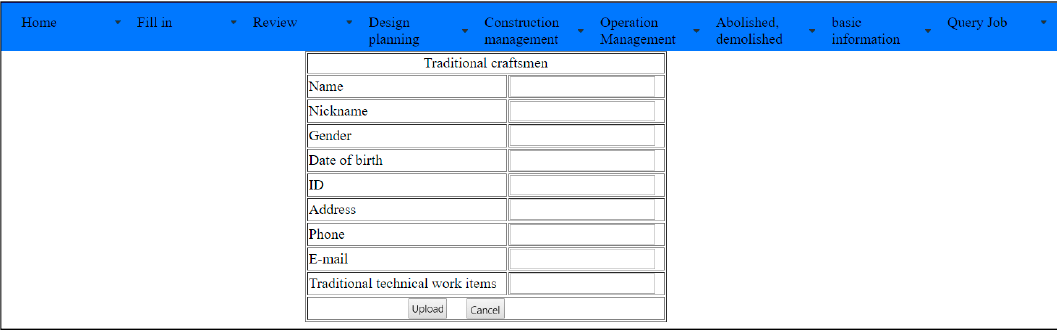
Figure 10. Information maintenance section on the management interface.